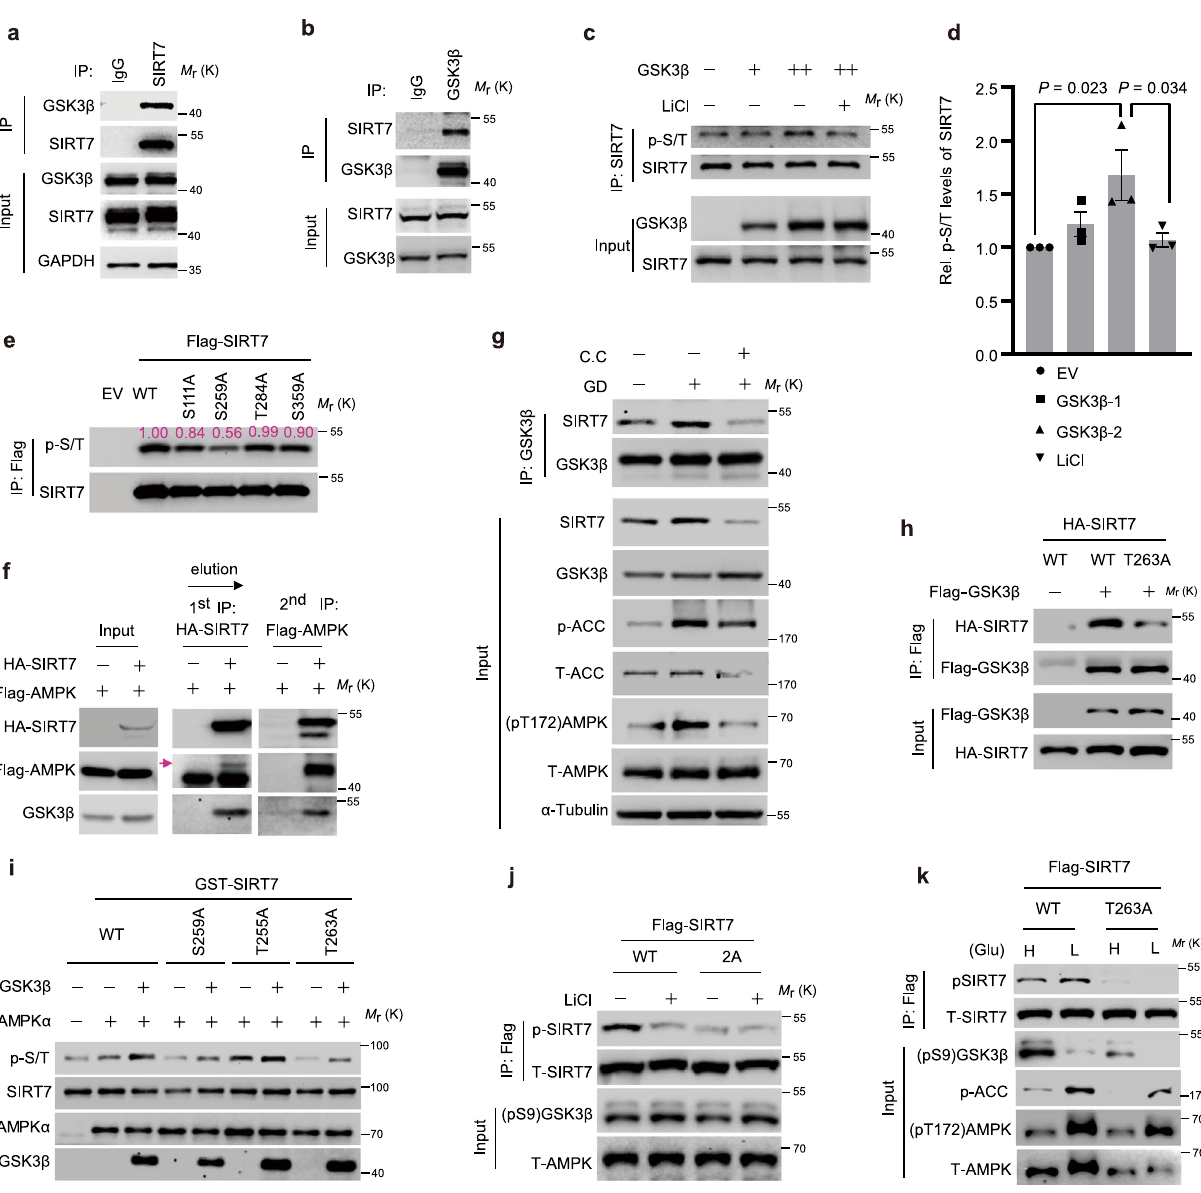
Fig. 2 AMPK primes SIRT7 phosphorylation by GSK3 β . a , b Immunoblots showing the interaction of endogenous SIRT7 and GSK3 β by immunoprecipitation of the indicated proteins. c , d Immunoblotting and related quanti fi cation ( n = 3 biologically independent samples) of SIRT7 pan p-S/T levels in HEK293 cells transfected with increasing amounts of GSK3 β plasmids with or without LiCl (10 mM) treatment; error bars: means ± SEM; P values were calculated by one-tailed Student ’ s t -test. e SIRT7 and the indicated mutants were overexpressed in HEK293 cells and then extracted for immunoblotting analysis of phosphorylation levels with an anti-pan-p-S/T antibody. The relative intensity measured by Image J ® and is shown the individual bands. f Immunoblotting analysis of the sequential immunoprecipitations based on anti-HA or anti-FLAG antibodies in HEK293 cells co- expressing ectopic HA-SIRT7 and Flag-AMPK. Arrow indicates the speci fi c band for FLAG-AMPK. g Immunoblots showing the binding of endogenous SIRT7 to GSK3 β in HEK293 cells under glucose starvation (1 h) or Compound C treatment (CC, 5 µ M). h Immunoblots showing the binding of WT-SIRT7 or T263A to GSK3 β in HEK293 cells transfected with the indicated plasmids. i Immunoblotting analysis of SIRT7 phosphorylation levels after in vitro kinase assays based on active GSK3 β and AMPK complexes immunoprecipitated from AICAR-treated HEK293 cells. SIRT7 phosphorylation was detected by probing with an anti-pan p-S/T antibody. j , k Immunoblots showing SIRT7 phosphorylation levels in HEK293 cells treated as indicated. The anti-p-SIRT7 antibody was generated by immunization with a Thr255/Ser259 phosphorylated peptide. Representative results were obtained from at least three independent experiments. Source data are provided as a Source Data fi